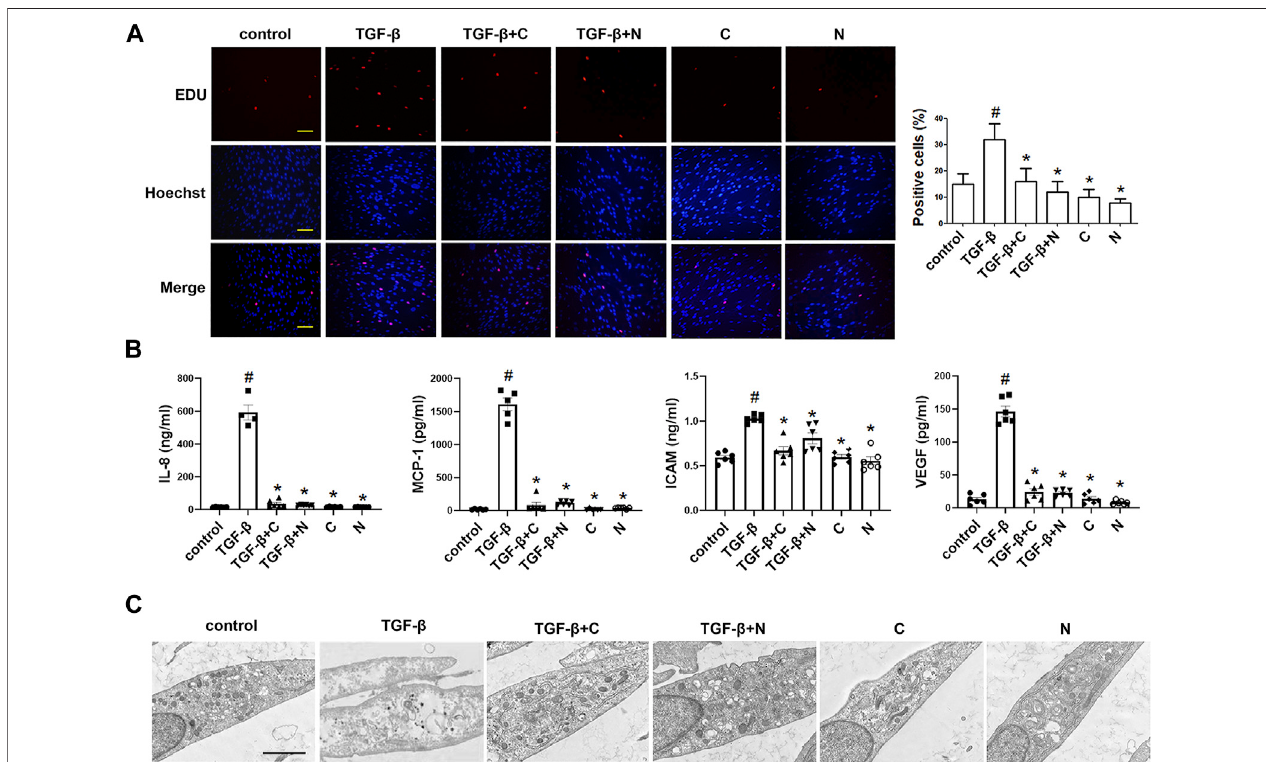
FIGURE 4 | Treatment with chloroquine inhibited TGF- β 1-induced proliferation, hypersecretion and hypertrophy in ASM cells (A) Effect of chloroquine on TGF- β 1- stimulatedhumanASMcellsasassessedbyEdUassay(magni fi cation,×200;scalebar,100 µm) (B) TheIL-8,MCP-1,ICAM-1,andVEGFlevelsinthesupernatantwere measured by ELISA (C) Effect of chloroquine on TGF- β 1-stimulated human ASM cells as assessed by transmission electron microscope (TEM) (magni fi cation, ×7000; scale bar, 2 µm). Values are the mean ± SEM of at least four independent experiments performed in triplicate. # p < 0.05 compared with the control, and * p < 0.05 compared with the TGF- β 1 group. C, chloroquine (5 μ m); TGF- β , TGF- β 1 (5 ng/ml); N, NAC (10